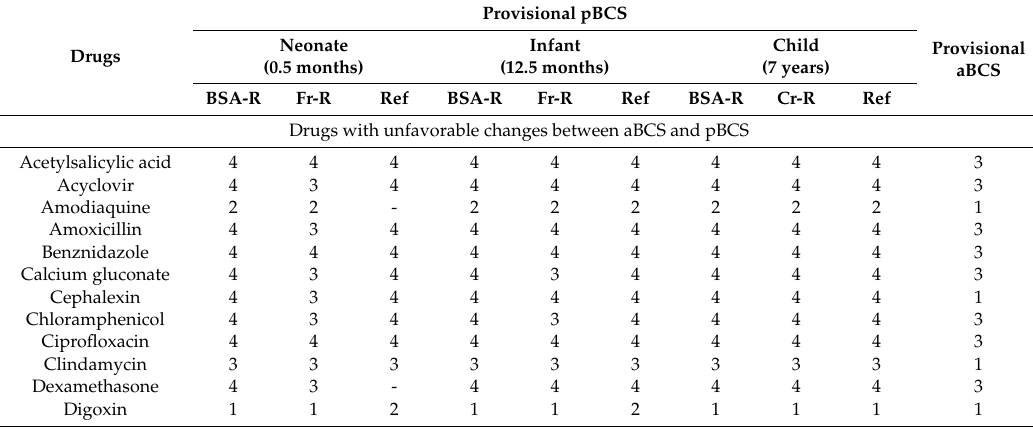
Table A1. Provisional pBCS classification of oral drugs from the WHO Model List of Essential Medicines for Children. Abbreviations: BSA-R, body surface dosage; Fr-R, Fried’s rule dosage; Cr-R, Clark’s rule dosage; Ref, referenced dosage; aBCS, adult